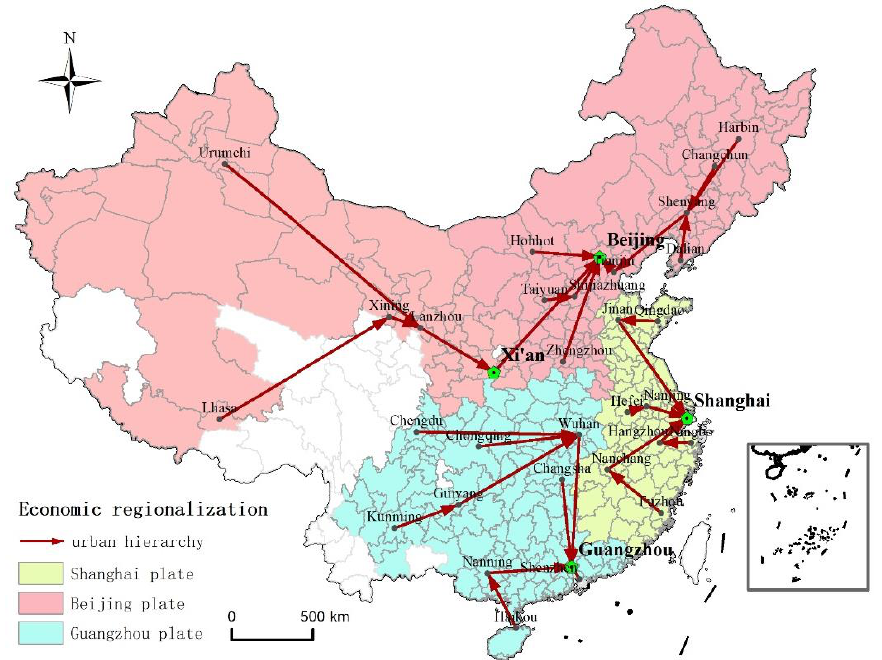
Figure 7. Hierarchical structure of major cities and economic spatial pattern (see the Appendix A for the detailed urban hierarchy). Each red line in the map points from one city to another city with higher attractiveness and the strongest connection to it.